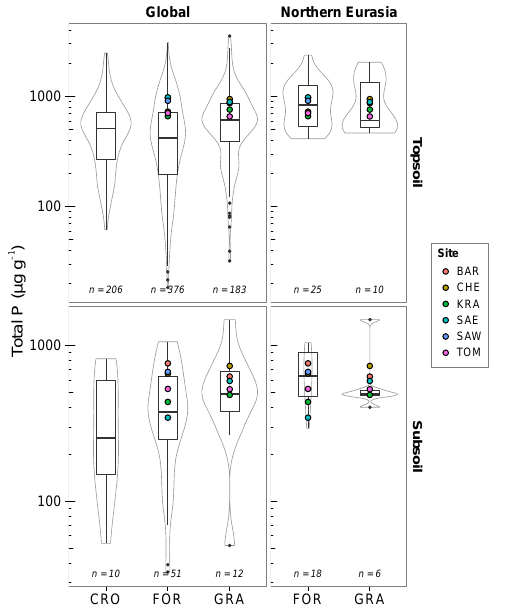
Figure 3. Comparison of total P concentrations in topsoils (about 0 to − 20cm) and subsoils ( − 20 to − 100cm depth) of south- western Siberia (coloured dots) with similar vegetation contexts (CRO: croplands; FOR: forests; GRA: grasslands) on the global scale and on the northern Eurasian scale (box and violin plots). The “ n ” provided indicates the number of individual points used to build the box and the violin